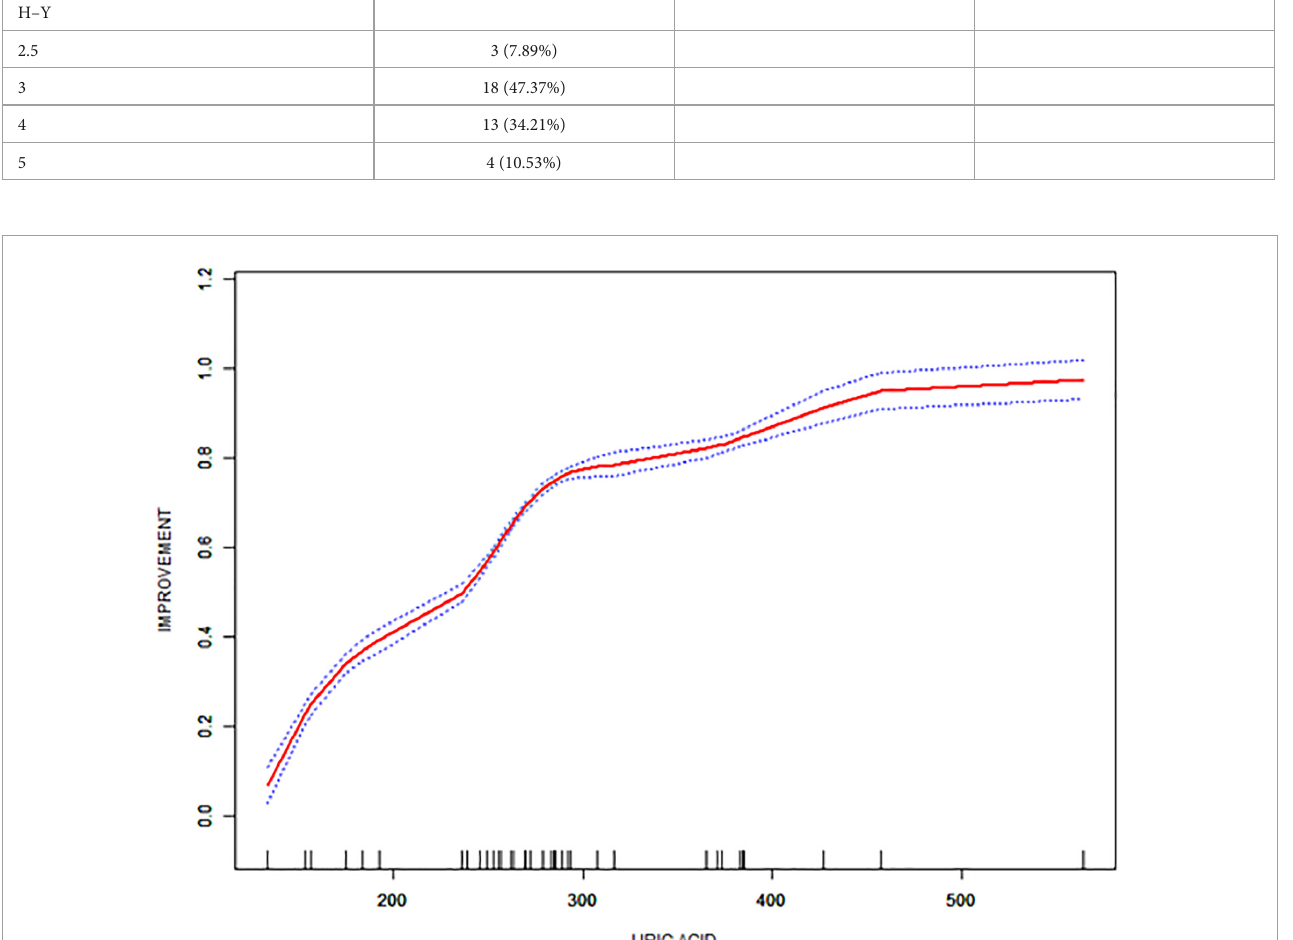
FIGURE1 Correlation of UPDRS-III score improvement rate with uric acid (UA) values in the enrolled patients.